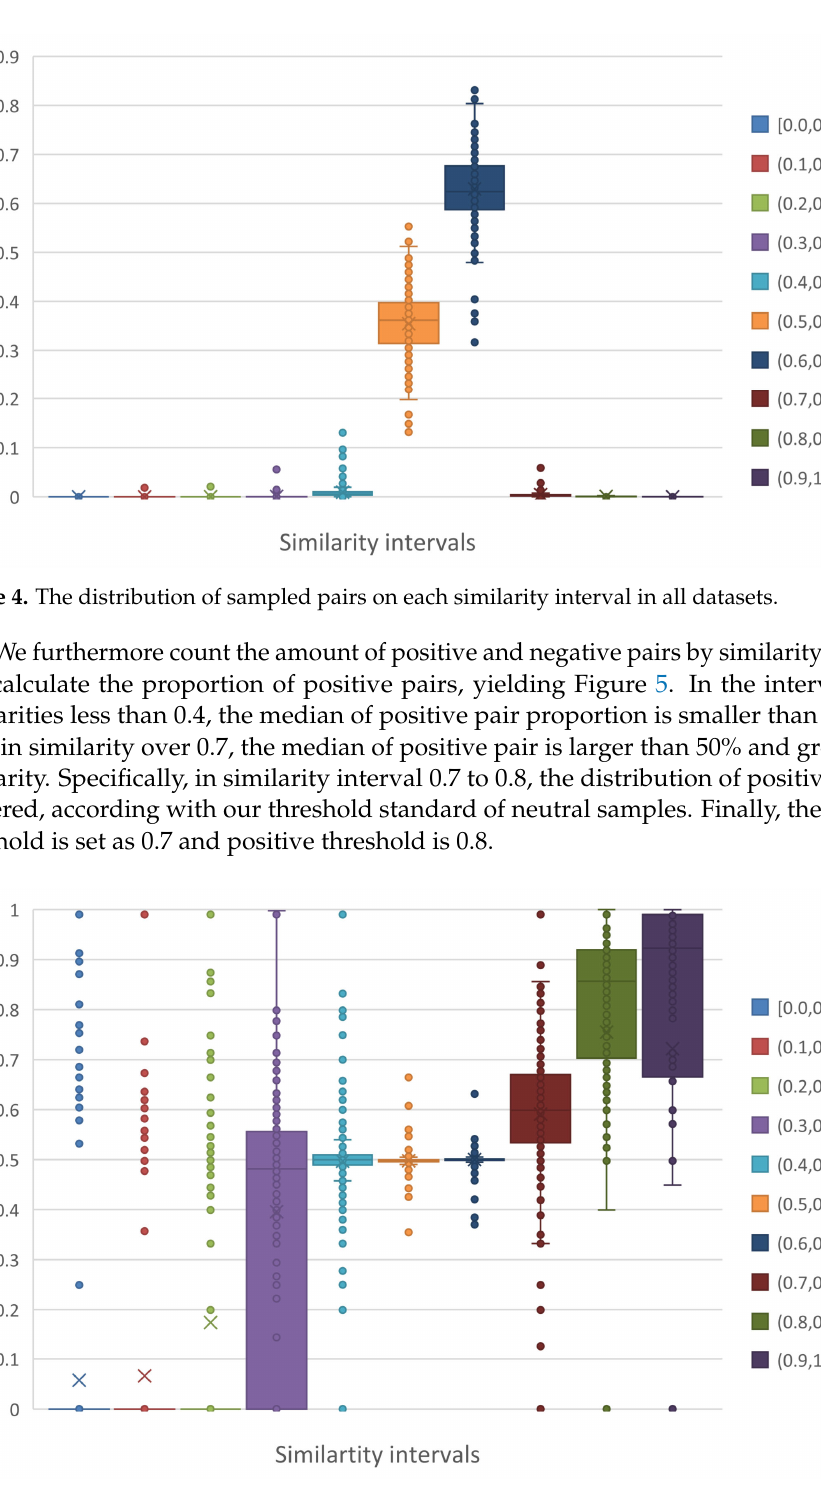
Figure 5. The proportion of positive pairs in each similarity interval in all